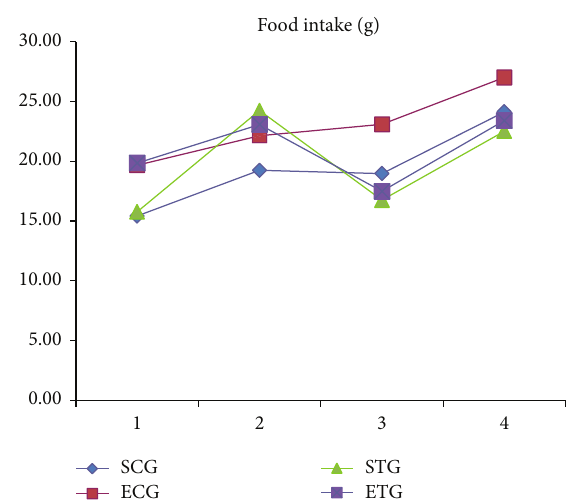
Figure 2: Average values of food intake (g) among the studied groups throughout the experimental period. Note: SCG: sedentary control group; ECG: exercised control group; STG: sedentary tucum˜a group; ETG: exercised tucum˜a group. 𝑃 value < 0.001 for all groups.